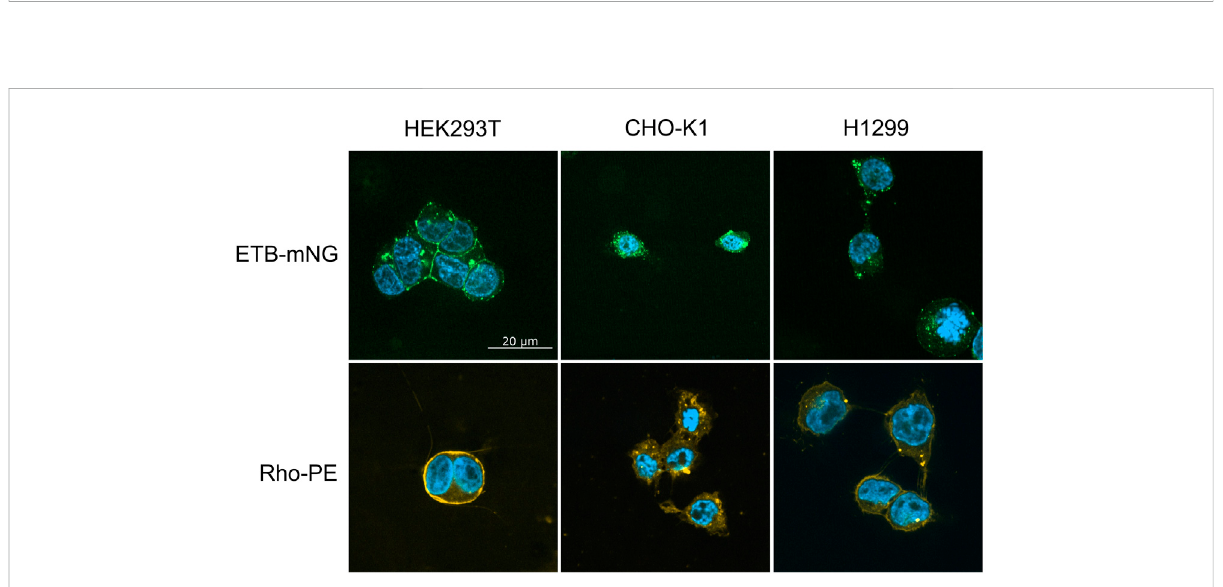
TransferofETB-mNGandRho-PEfromNDsintodifferentmammaliancelllines.0.5 µMofNDs(DEPG)containingeitherETB-mNGor2%Rho- PEwereincubatedfor4 hwithHEK293T, CHO-K1, orH1299cells. Afterwashingand fi xation, cellswereanalyzedusing aspinning disk fl uorescence microscope. Representative images are